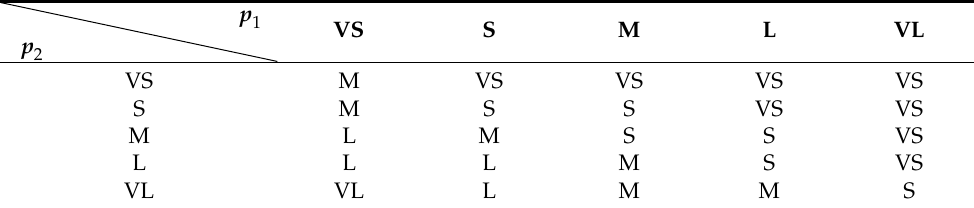
Table 4. Fuzzy rule table for determining the degree to which a pixel belongs to the crack class. p